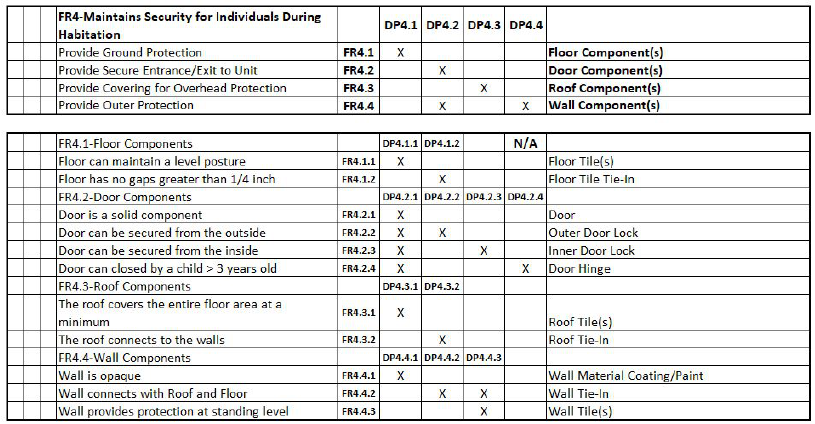
Figure 22. AD Top-Level Design Mapping of DPs for